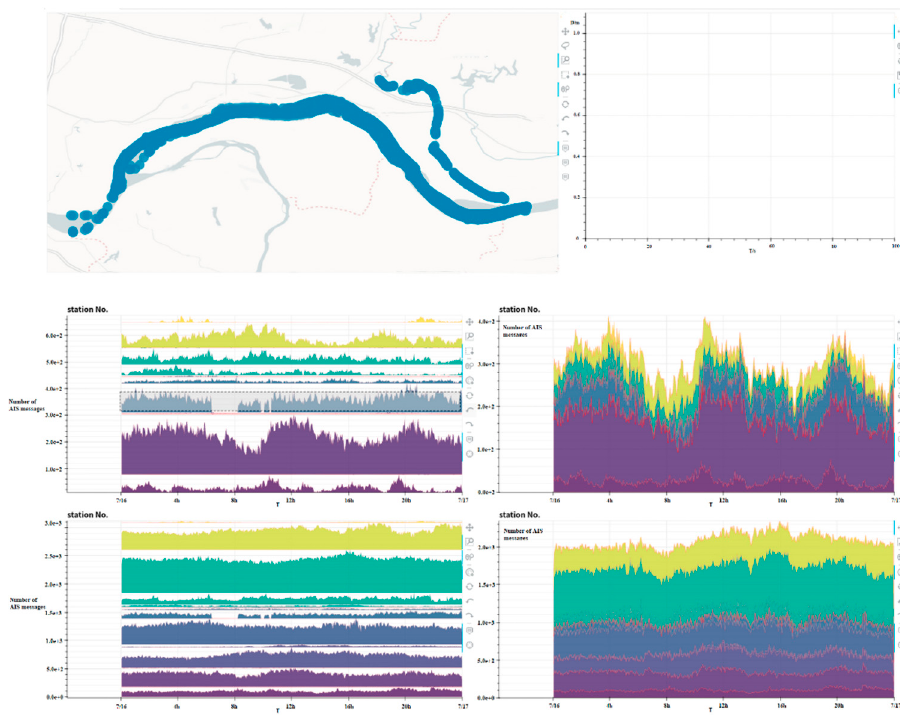
Figure 19. Stack graph of a base station.